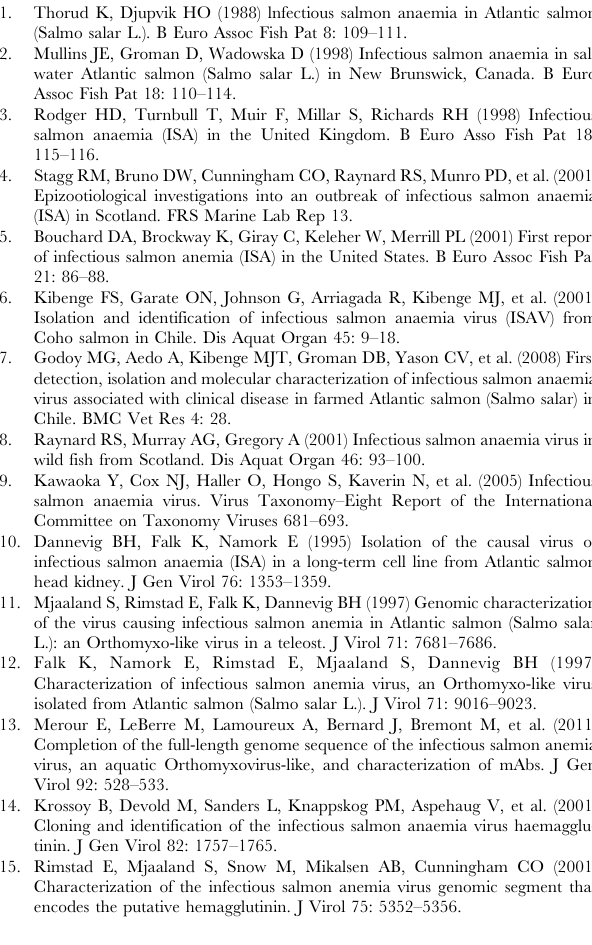
one Chilean isolate with insert (EU130923) and two reference isolates without insert (GU830907 and EU851044). (DOC) Figure S2 Nucleotide sequence alignment for HPR region of segment 6. Sequentially: HPR0, HPR2, HPR5, HPR7b and HPR8. (DOC) Table S1 %GC for segment 5 primer sets of three isolates with/without insert (Upper table) and %GC for segment 6 primer sets of five isolates (Bottom table). Table S2 Primer sets (forward and reverse) for PCR- DGGE